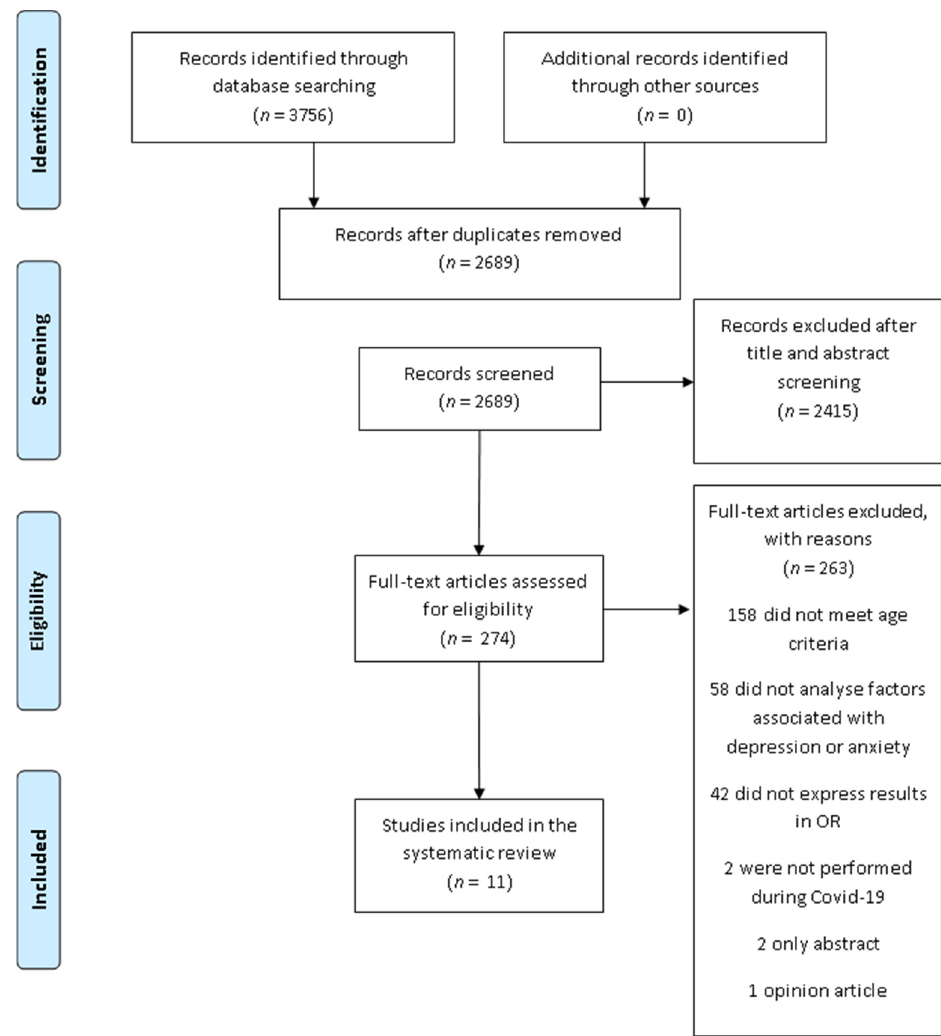
Figure 1. PRISMA flow-chart of the study selection process.